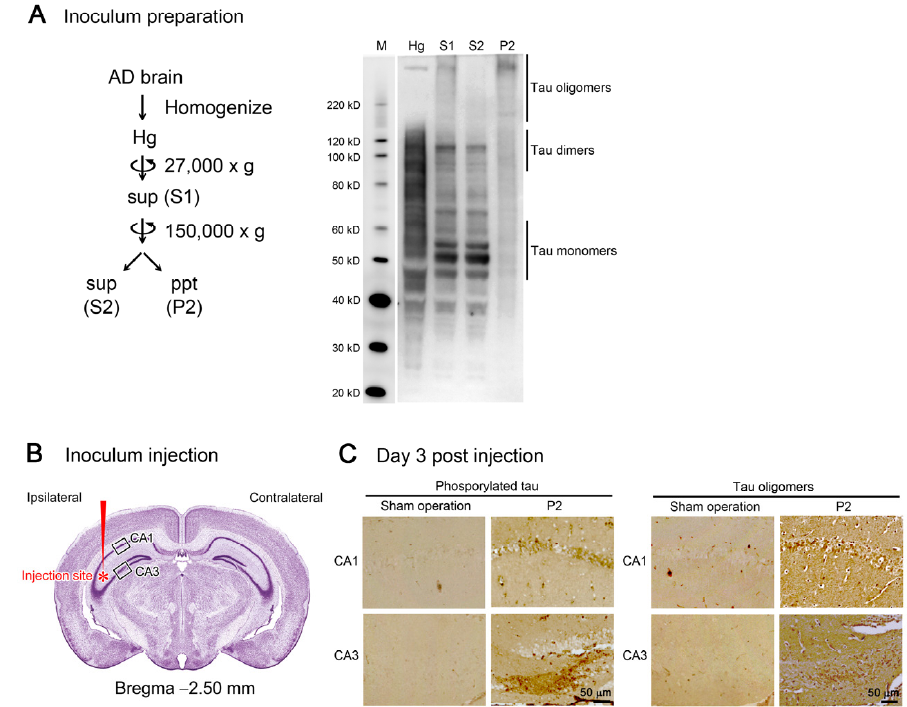
Figure 1. Preparation and injection of tau oligomer-rich inoculum. ( A ) AD brain homogenate (Hg) was centrifuged to remove insoluble materials. The supernatant (S1) was further separated by ultracentrifugation into soluble (S2) and insoluble (P2) fractions. In Western blot analysis, tau monomers and dimers were primarily collected in S2 fraction, whereas tau oligomers more than 120 kD were rich in P2 fraction. M, MagicMark XP Western Protein Standard (Invitrogen, Carlsbad, CA, USA). ( B ) P2 fraction was injected into a unilateral hippocampus of 8-month-old tau264 mice. ( C ) Three days after the injection, brain sections were examined for phosphorylated and oligomeric tau species. These pathogenic molecules were detected within cells in the injection site, indicating their successful internalization. Intranasal rifampicin treatment was started 1 week after the